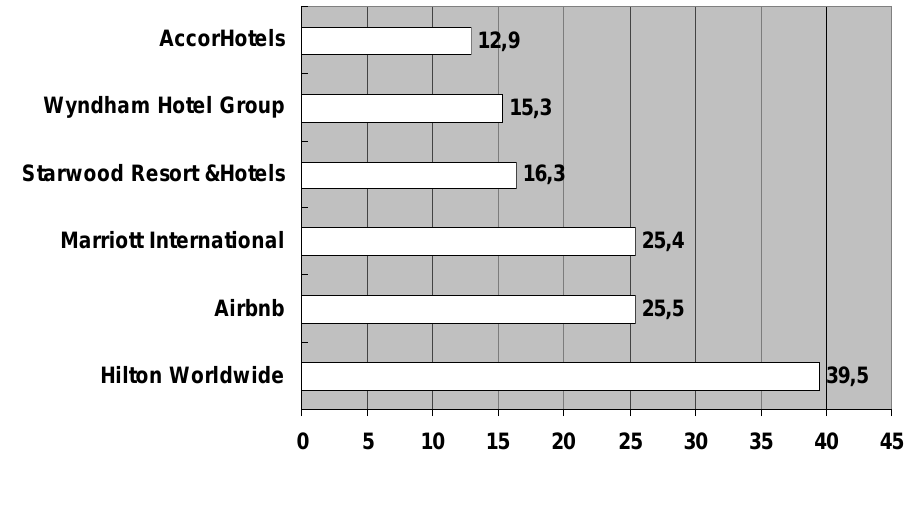
Figure 3: Global Hotel Groups Market Capitalisation versus Airbnb (in billion US